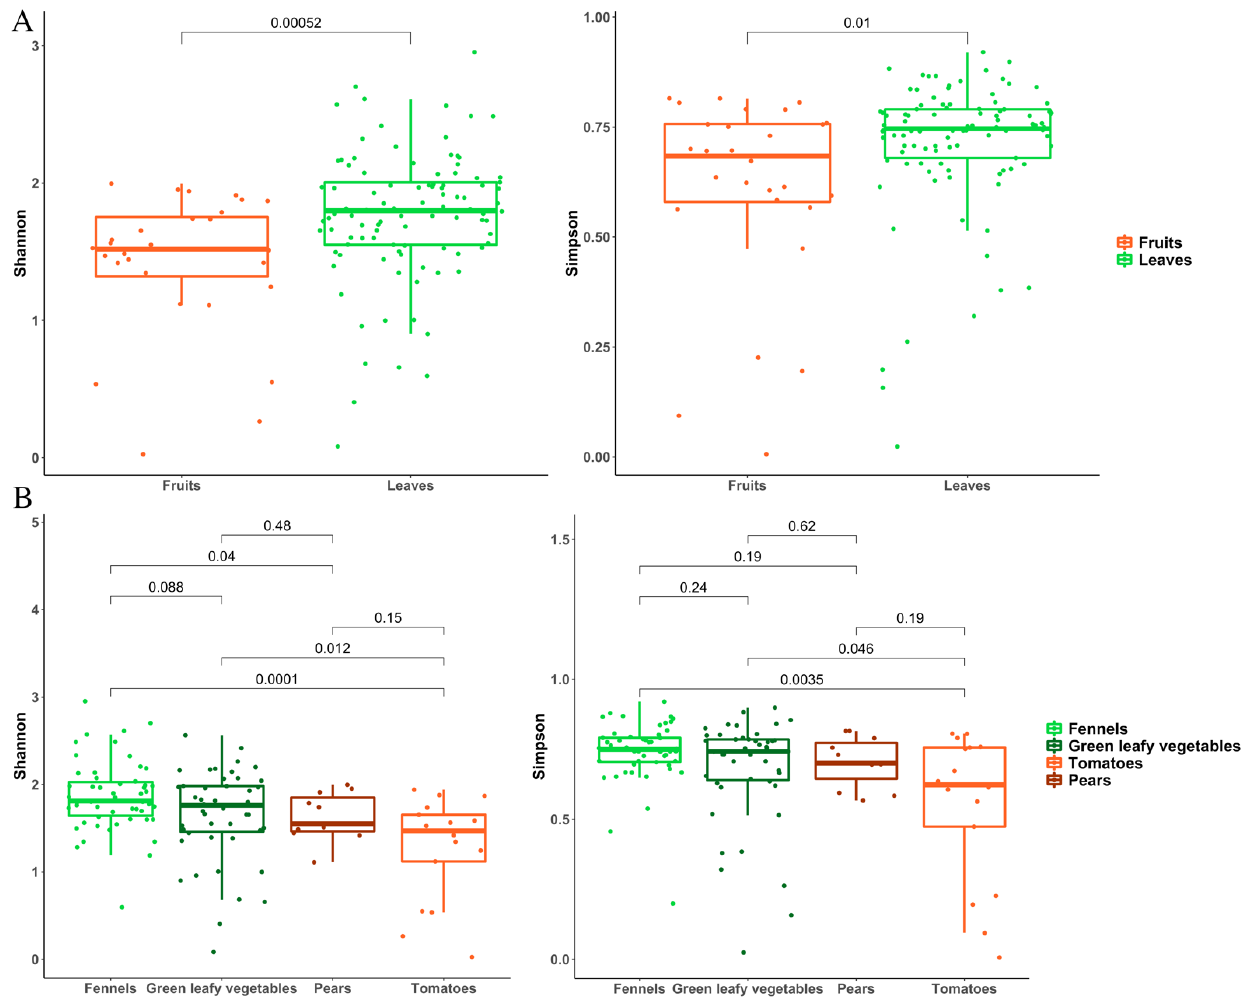
Figure 6. Fungal alpha diversity indices compared between ( A ) fruits and leaves and ( B ) the four types of F&V.